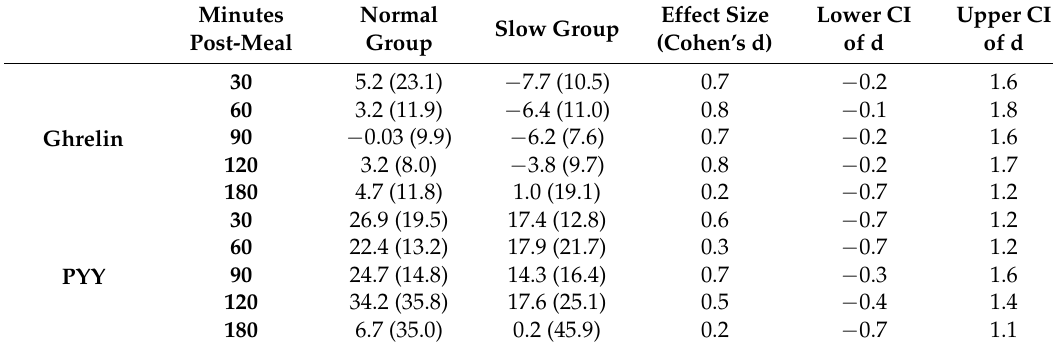
Table A4. Change in satiety hormone levels (ghrelin and PYY) from baseline (mean; SD). Minutes